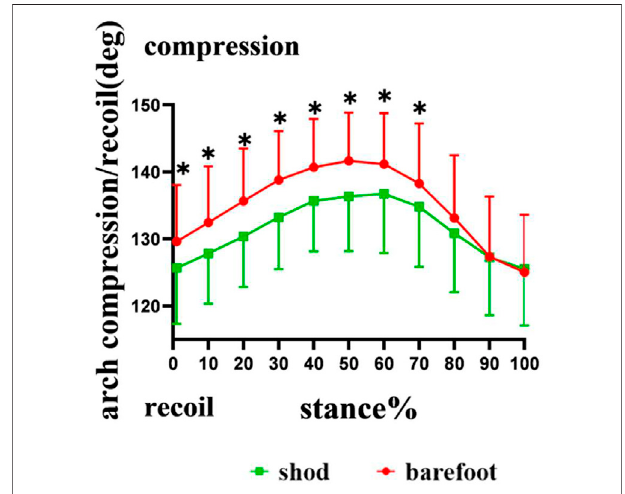
FIGURE 8 | MLA compression and recoil during the stance phase. *: signi fi cant differences existed between the shod and barefoot conditions, p < 0.05.